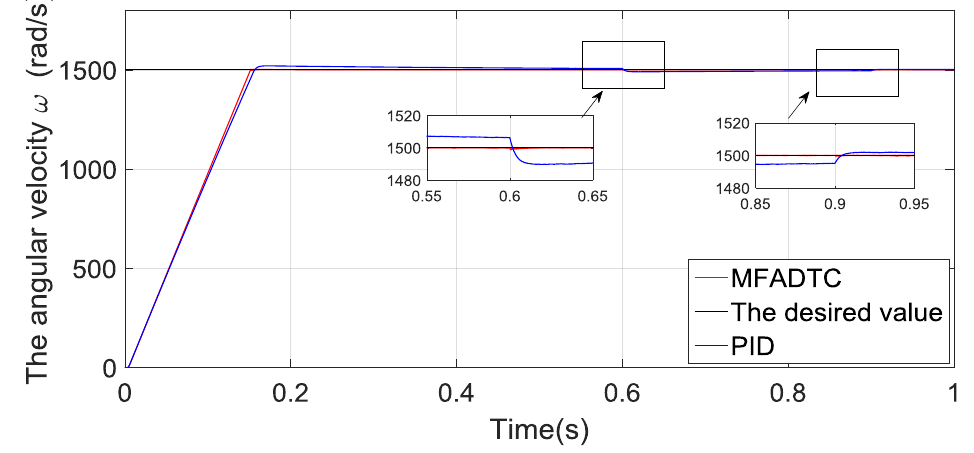
Figure 6. Comparison of speed anti-jamming ability between PID and MFADTC.